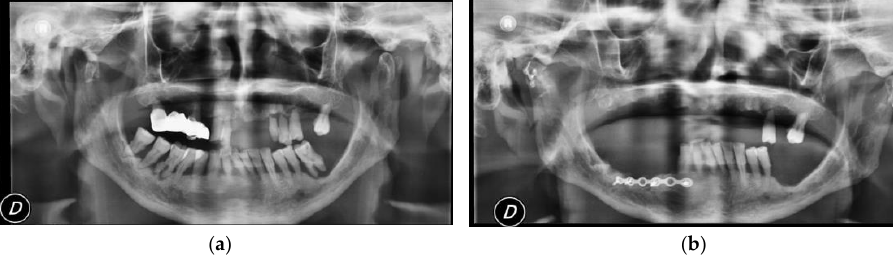
Figure 3. ( a ) Pre-operatory panoramic X-ray; ( b ) post-operatory panoramic X-ray of patient #3.